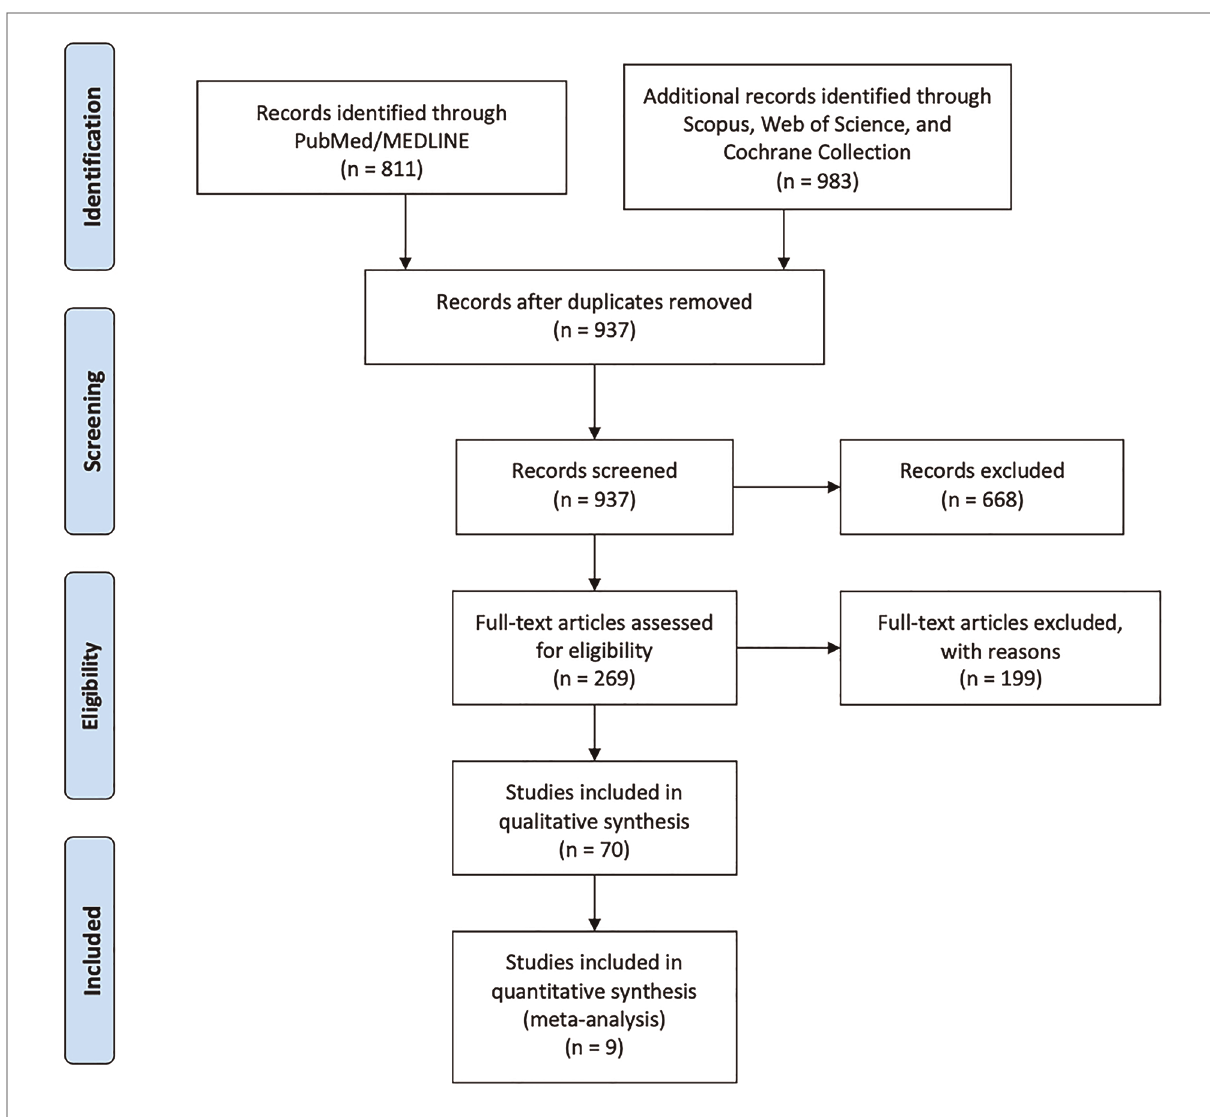
FIGURE 1 Diagram of work fl ow in the systematic review and